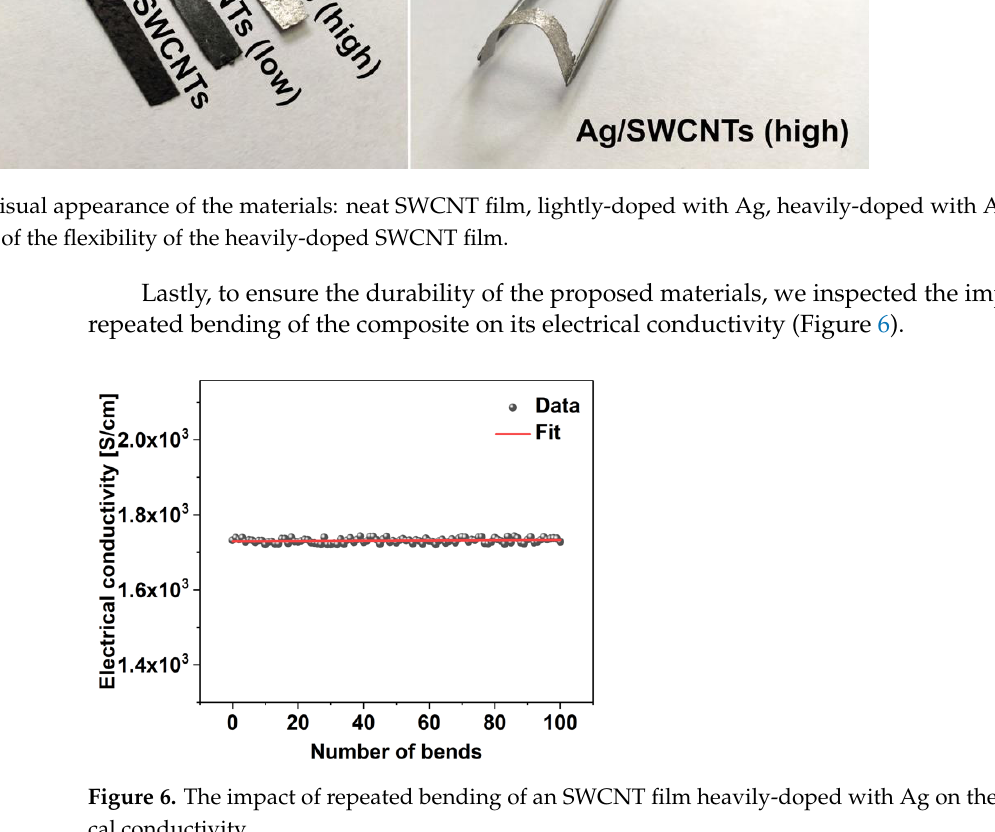
Figure 6. The impact of repeated bending of an SWCNT film heavily-doped with Ag on the electri- cal conductivity.